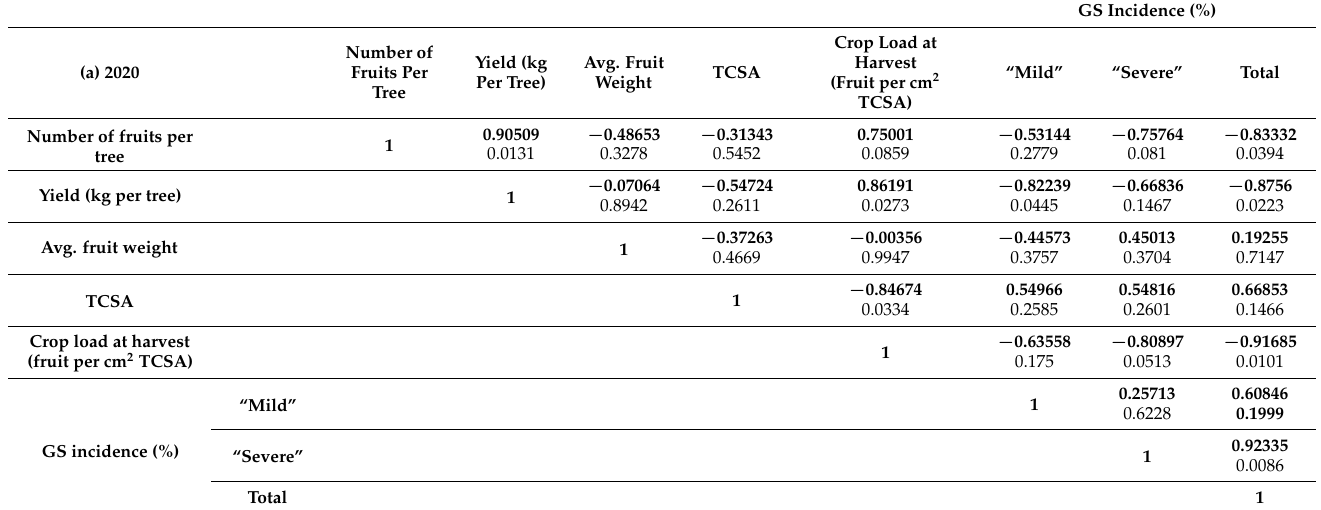
Table 6. Correlation of “mild”, “severe”, and total green spot (GS) incidence (%) and productivity parameters in (a) 2020 and (b) 2021. Pearson correlation coefficients are in bold, with respective p -values below for